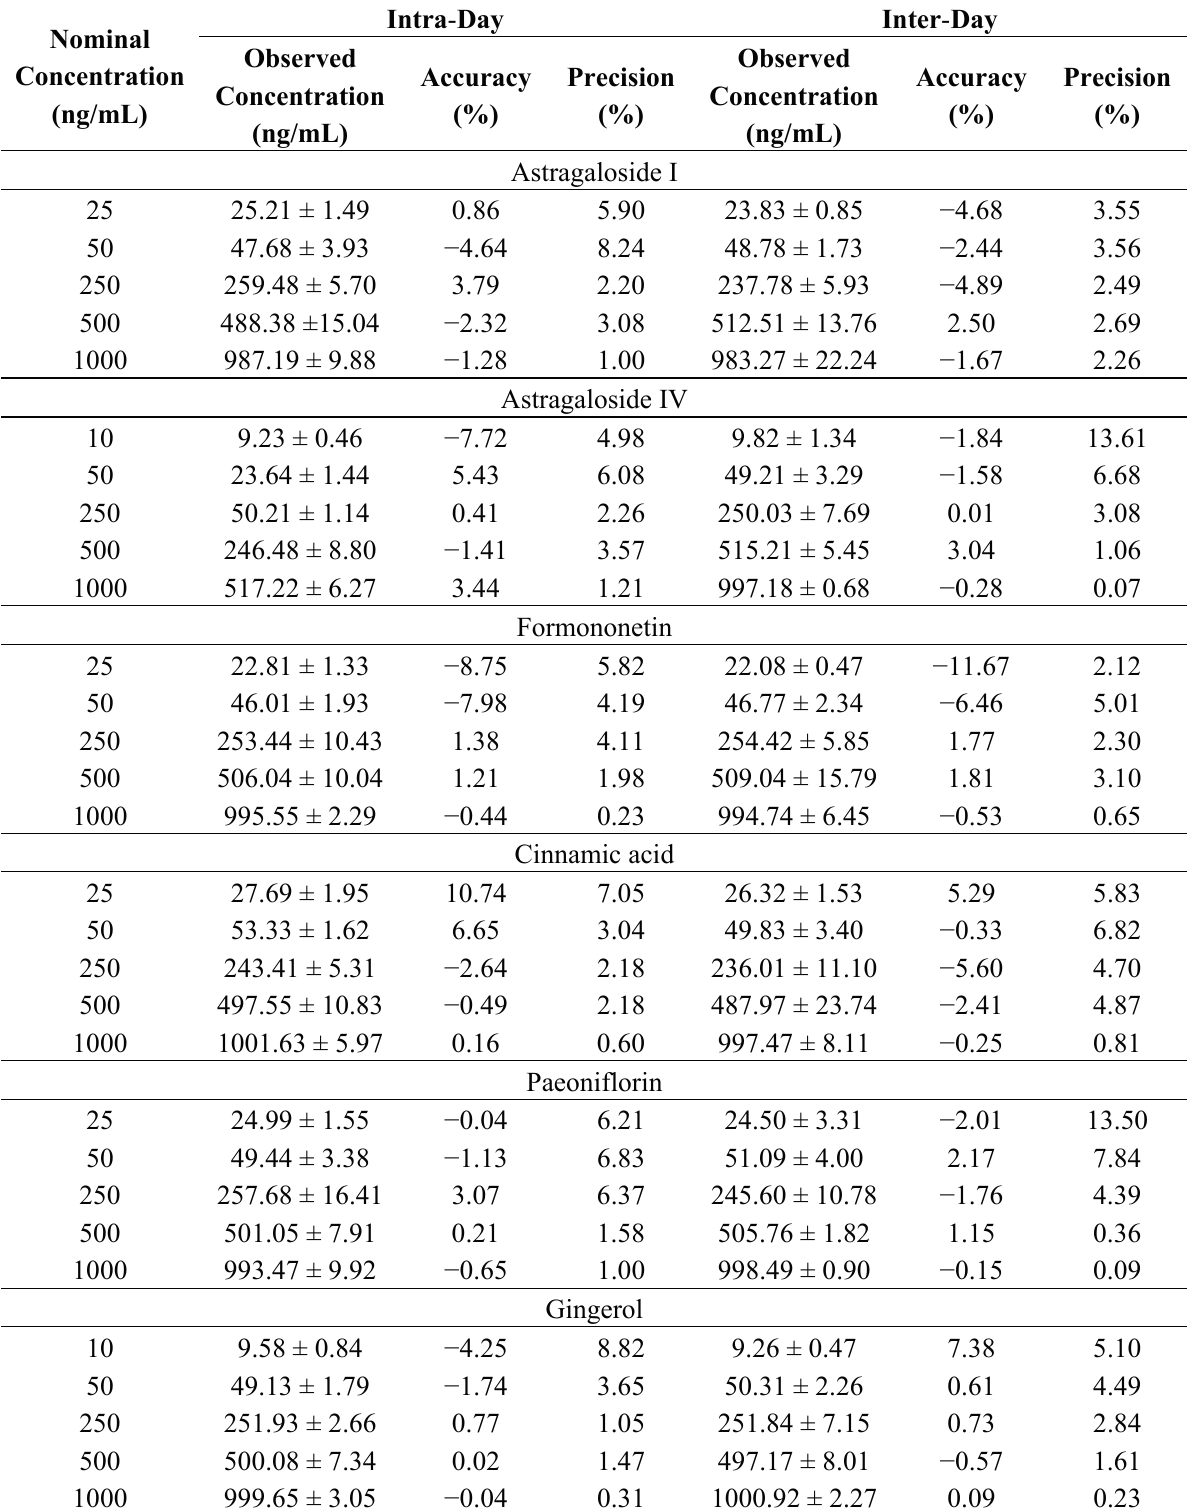
Table 2. Intra-day and inter-day precision and accuracy of the six active components of